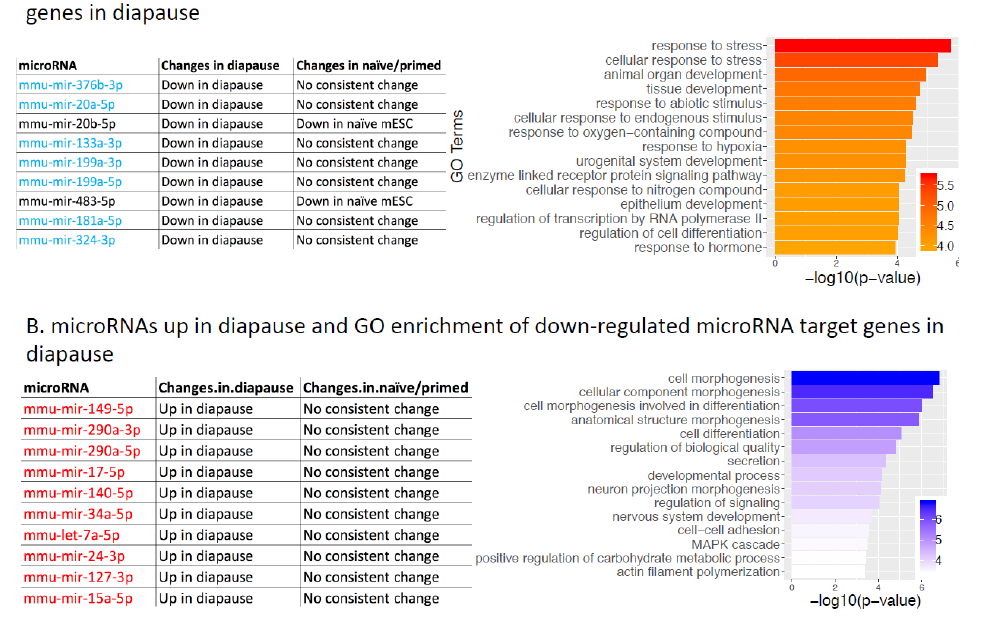
Figure 5. Consistent microRNA changes across human and mouse pluripotency: ( A ) Left panel : microRNAs with lower expression in the diapause state compared to reactivated state. MicroRNAs that are expressed lower only in diapause but not in the naïve state are highlighted in blue. Right panel : Gene ontology enrichment of microRNA target genes with higher expression in mouse diapause embryos compared to post-implantation embryos (the microRNA regulators are lower in diapause, shown on the left panel ). The x-axis is the negative log10 of enrichment p -value (larger means more significant). ( B ) Left panel : Top 10 microRNAs with highest expression in the diapause state compared to reactivated state. These microRNAs are highlighted red because they are higher in diapause but not in naïve state. Right panel : Gene ontology enrichment of microRNA target genes with lower expression in mouse diapause embryos compared to post-implantation embryos (the microRNA regulators are higher in diapause, shown on the left panel). 3. Materials and Methods Raw mRNA-seq data from Sperber et al. [27] and Theunissen et al. [45] were aligned to hg19/GRCh37 with STAR aligner57. Transcript quantification was performed with htseq-count from HTSeq package58 using GENCODE v15. Differential expression analysis was performed with DESeq after filtering out genes whose total read count across samples are below the 40th quantile of all genes.